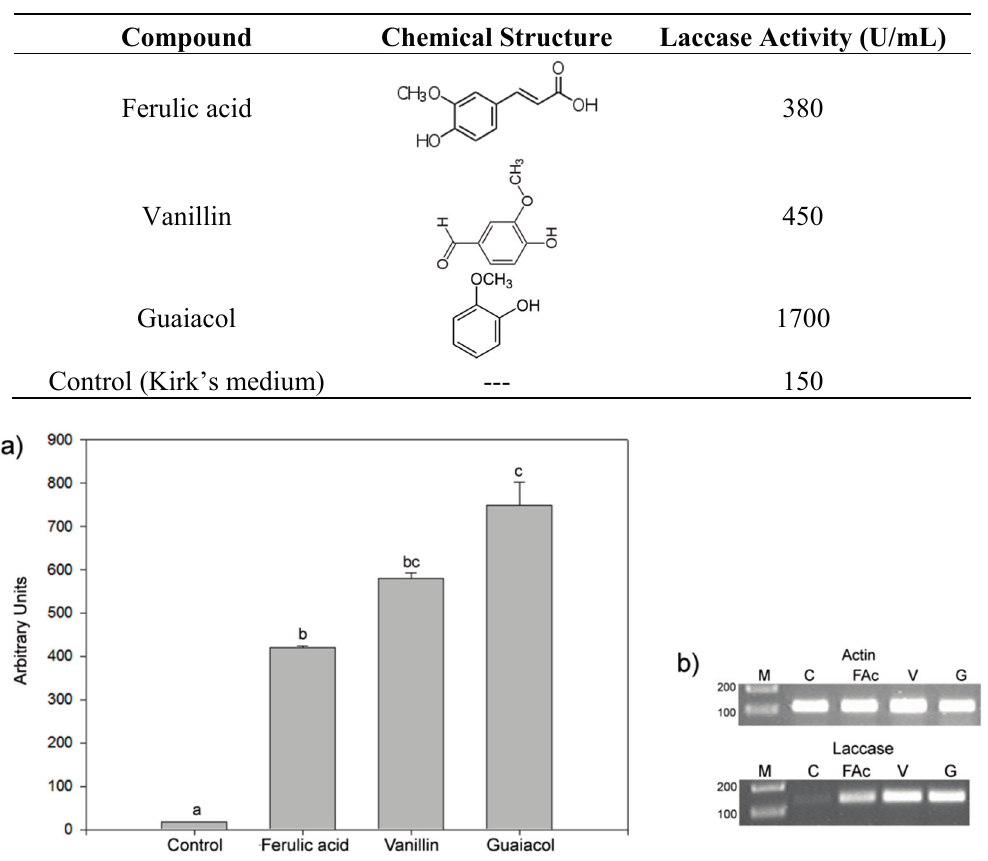
Table 1. Production of T. hirsuta (Bm-2) laccase in basal medium supplemented with different aromatic